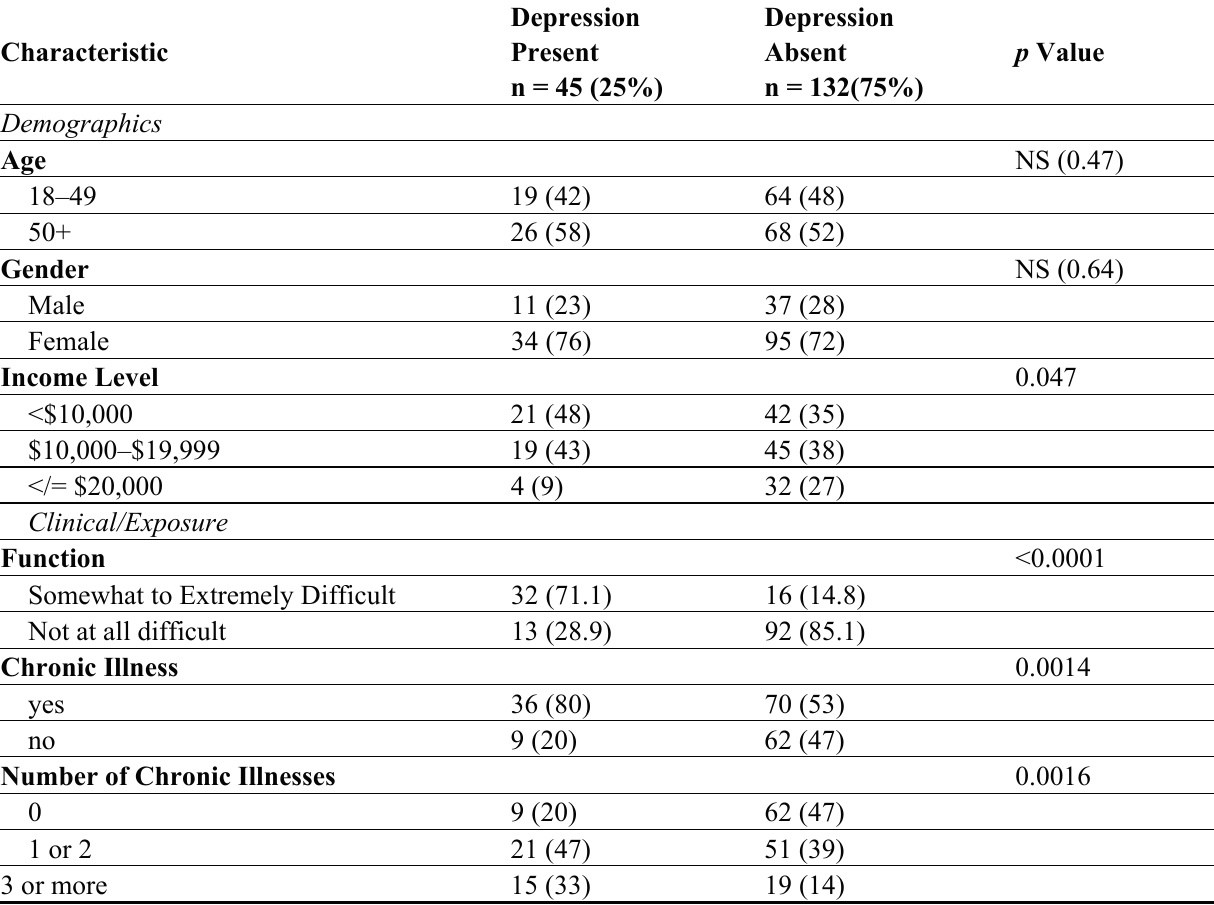
Table 2. Bivariate Associations with PHQ-9 score indicative of